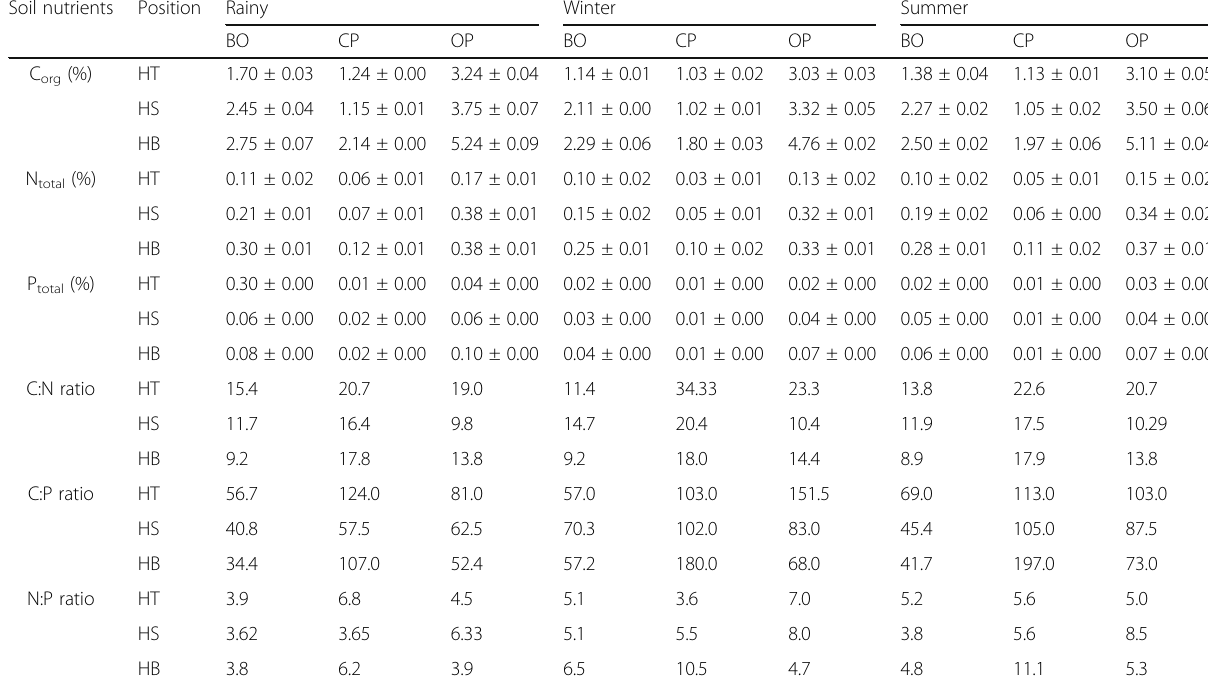
Table 1 Soil chemical properties in different forest types (means ± 1 S.E.) Soil nutrients Position